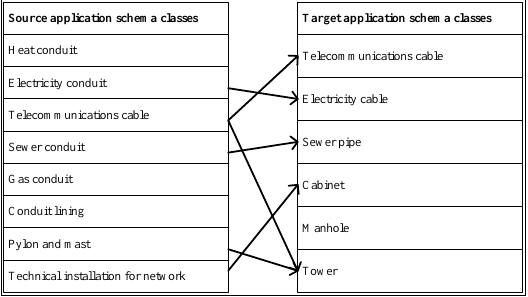
Figure 6. Simple reclassification prepared with the use of ontology